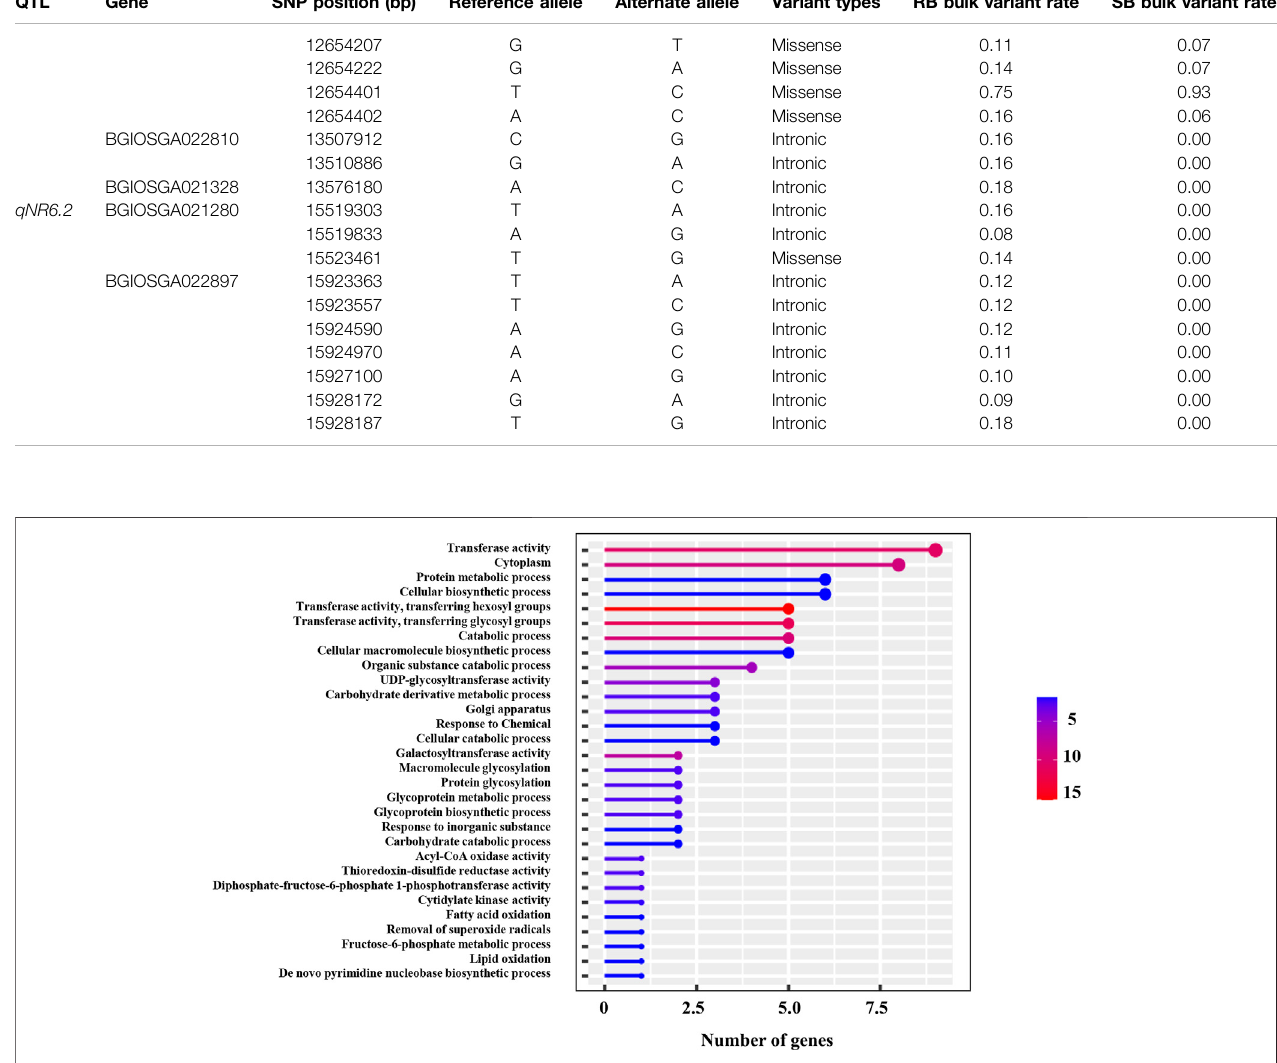
FIGURE 6 | GO annotation of 19 candidate genes identi fi ed in qNR2.1 , qNR4.1 , qNR6.1 , and